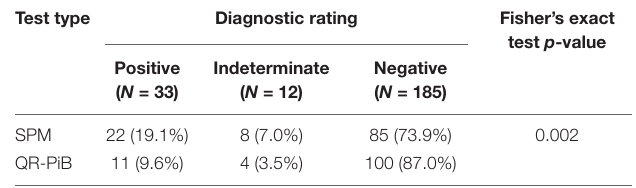
TABLE 4 | Diagnostic rating by test type.